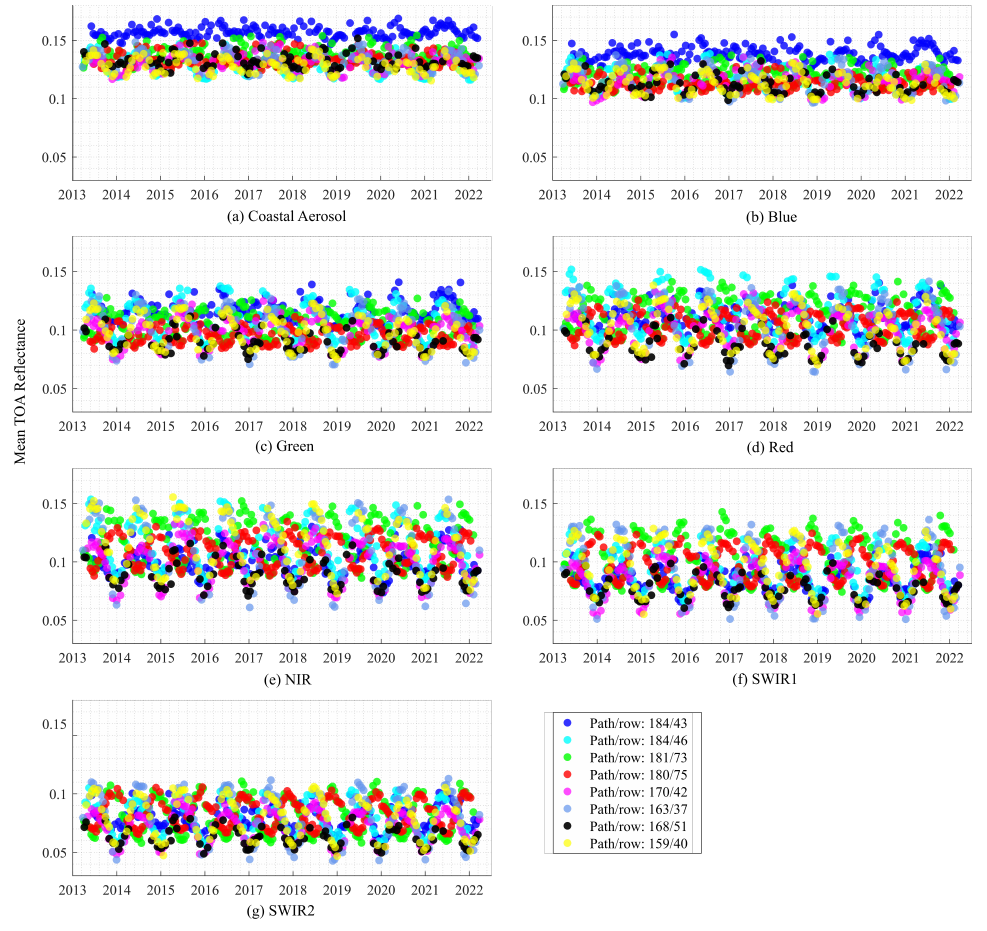
Figure 3. L8 dark target TOA reflectance of eight WRS-2 paths/rows for seven spectral bands.